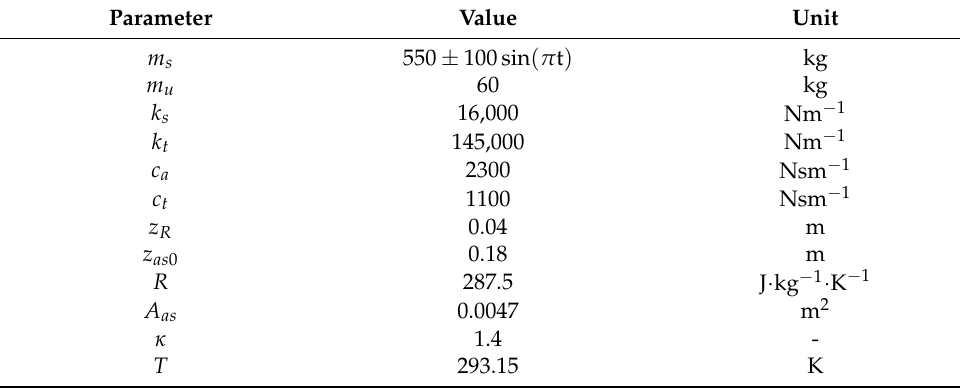
Table 1. Pneumatic vehicle suspension parameters.